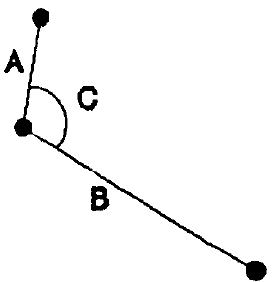
Figure 4. Liebe’s parameters, 2 inter-star angles and 1 interior angle (reprinted from